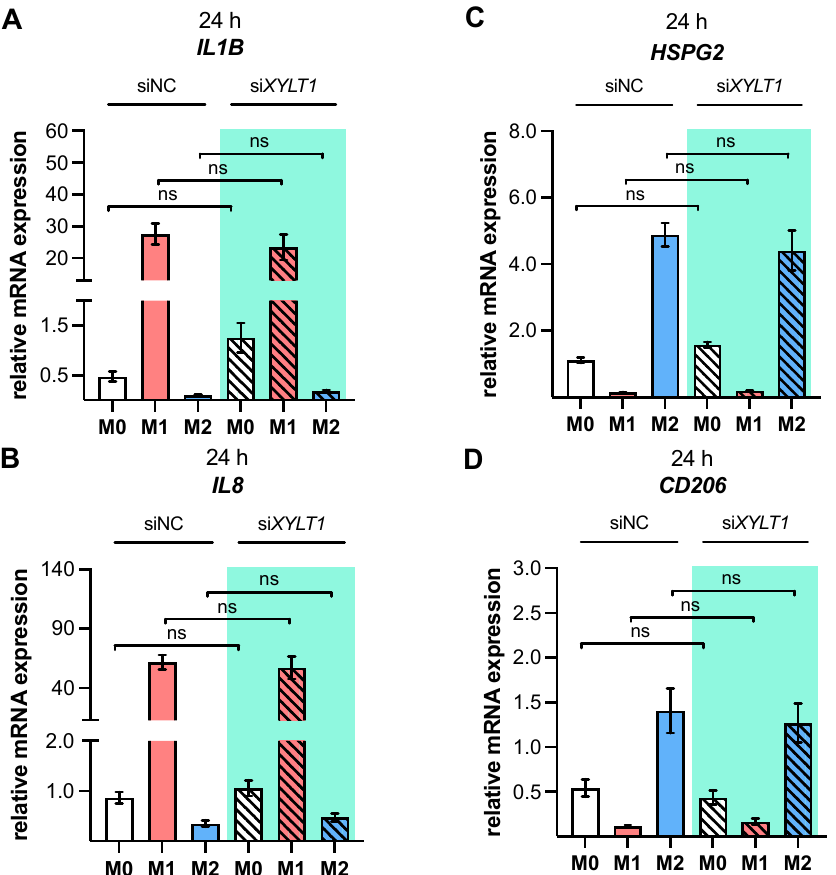
Figure 5. The mRNA expressions of two representative M1- and M2-like polarization state markers after siRNA-mediated XYLT1 knockdown of polarized M-M Φ . Monocytes were differentiated into macrophages using M-CSF. On day 5, M-M Φ were treated with a non-targeting negative control siRNA (siNC) or an siRNA targeting XYLT1 (si XYLT1 ). On day 6, M-M Φ were stimulated with IFN- γ /LPS (M1), IL-4 (M2), or with no additive (M0). Cells were harvested after a polarization time of 24 h, in order to determine the relative gene expressions of ( A ) IL1B , ( B ) IL8 , ( C ) HSPG2 and ( D ) CD206 , via qRT-PCR using the ∆∆ C T method. The data (n, sample = 3; n, biological = 2; n, technical = 3) were analyzed using a one-way ANOVA, followed by Tukey’s multiple comparison tests, and expressed as mean ± SEM. ns (not significant).